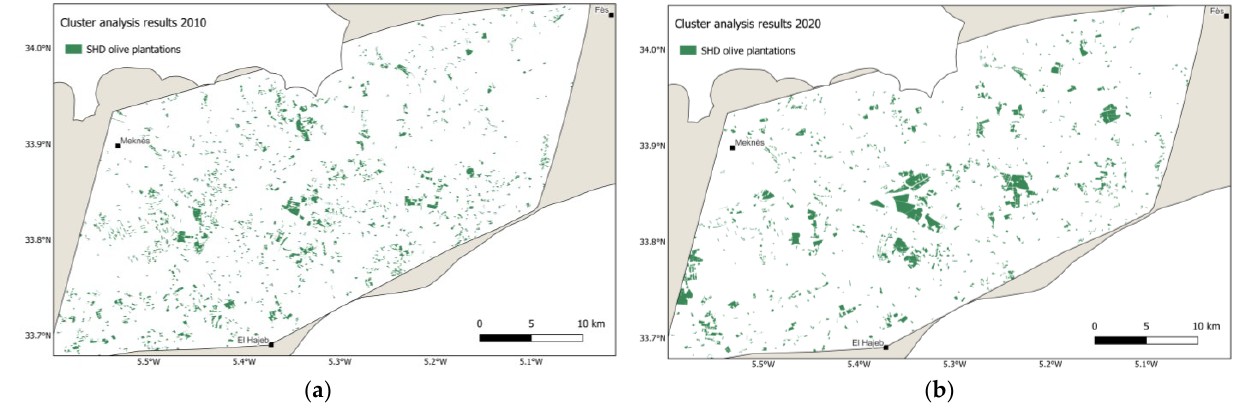
Figure 12. Spatial distribution of the detected olive cluster in the Saïss plain in 2010 ( a ) and 2020 ( b ).